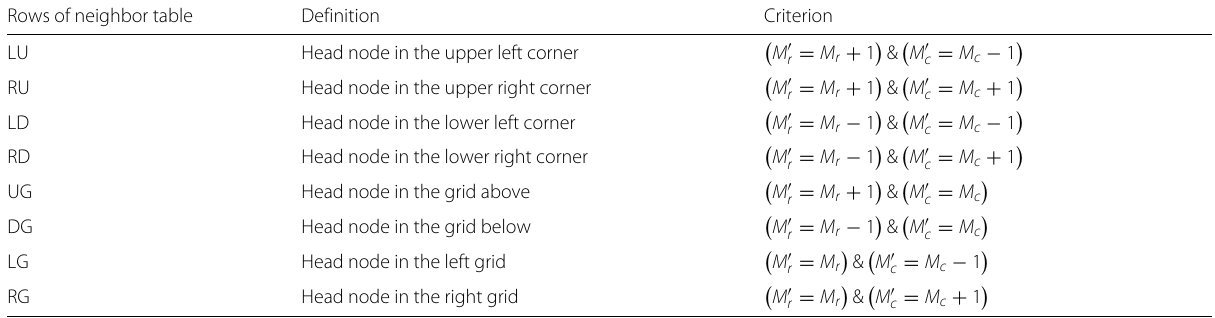
Table 3 The neighbor table and corresponding criterion Rows of neighbor table Definition